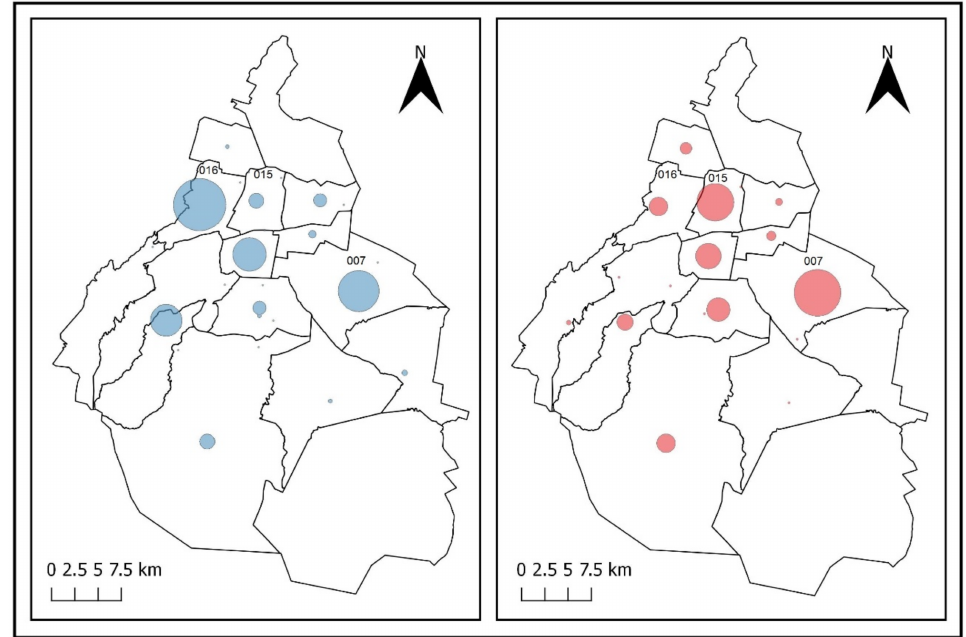
Figure 4. Reports of gunshots pre-COVID-19 (blue) and during COVID-19 (red) in Mexico City. The numbers on the map represent Miguel Hidalgo (016), Cuauht é moc (015) and Iztapalapa (007). Source: Authors’ own with QGIS